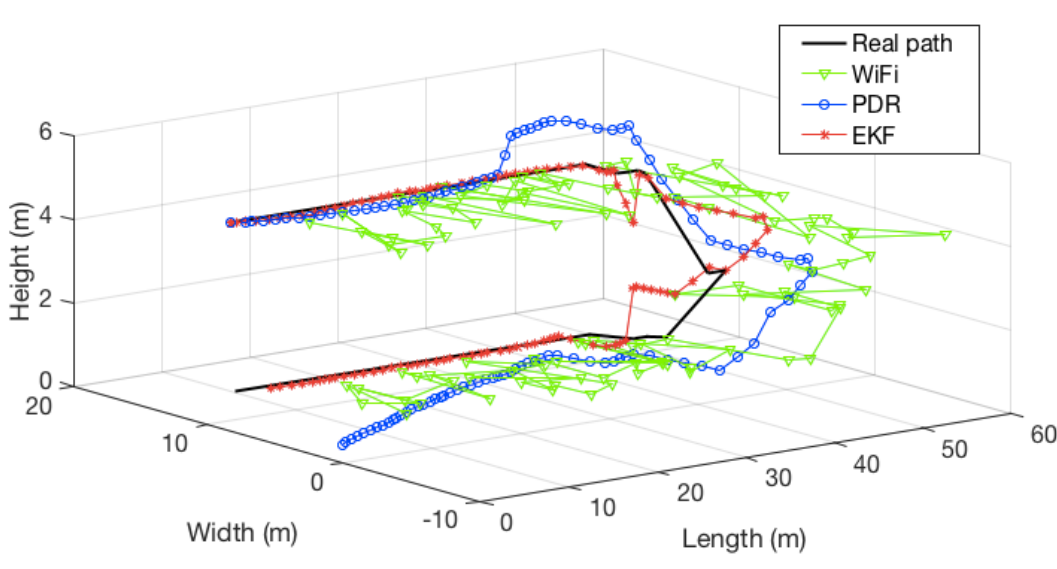
Figure 8. Real path of the target and results of positioning in the 3D